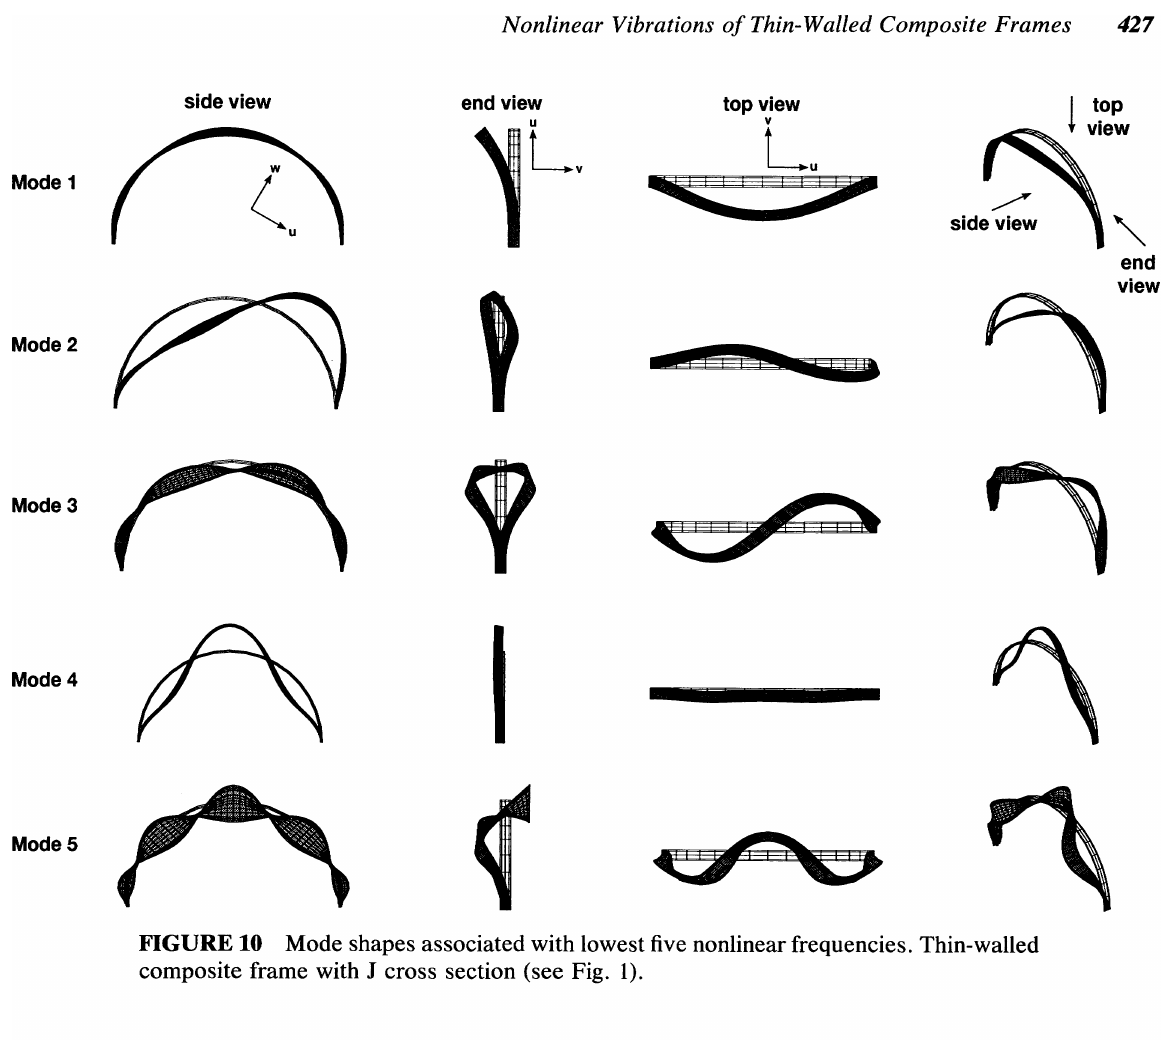
FIGURE 10 Mode shapes associated with lowest five nonlinear frequencies. Thin-walled composite frame with J cross section (see Fig.